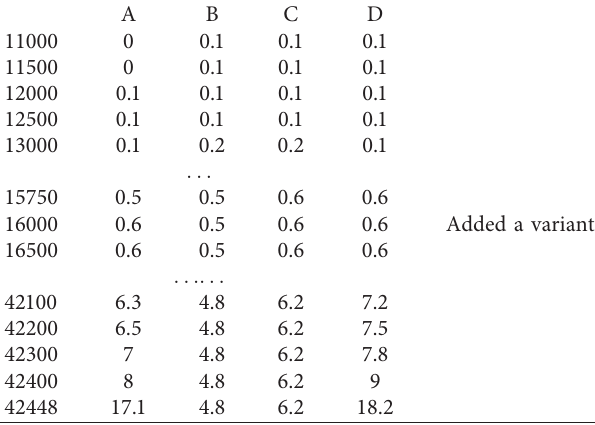
Table 8: Partial test data of variable amplitude two-hole test specimen 03 (complement).